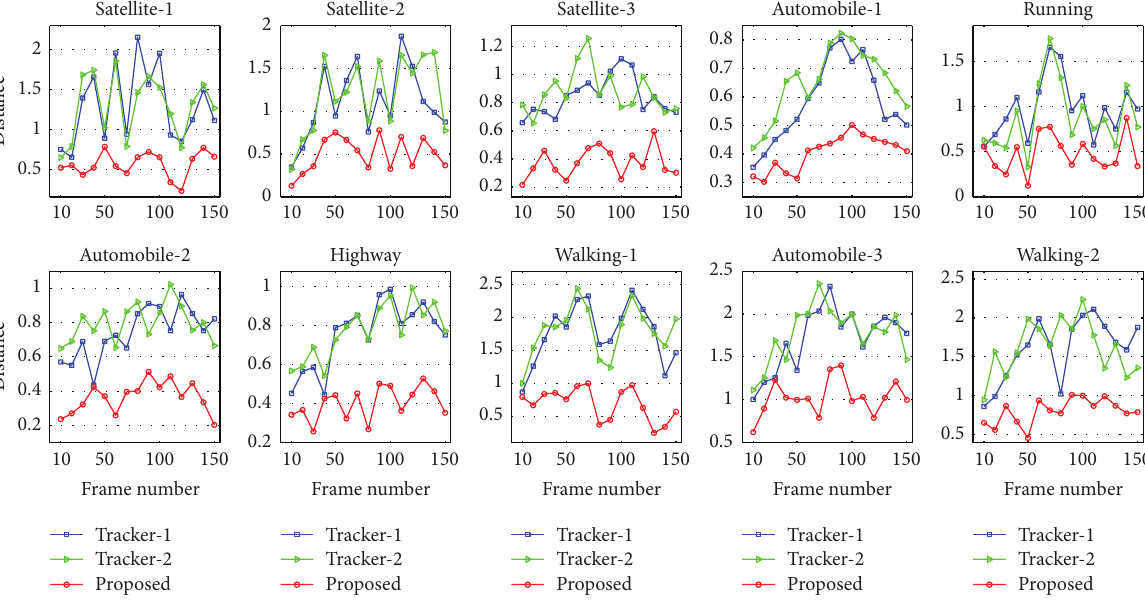
Figure 6: Bhattacharyya distances between the tracking method and the artificial markers. Red curve: our proposed method; blue curve: Tracker-1 in [27]; green curve: Tracker-2 in